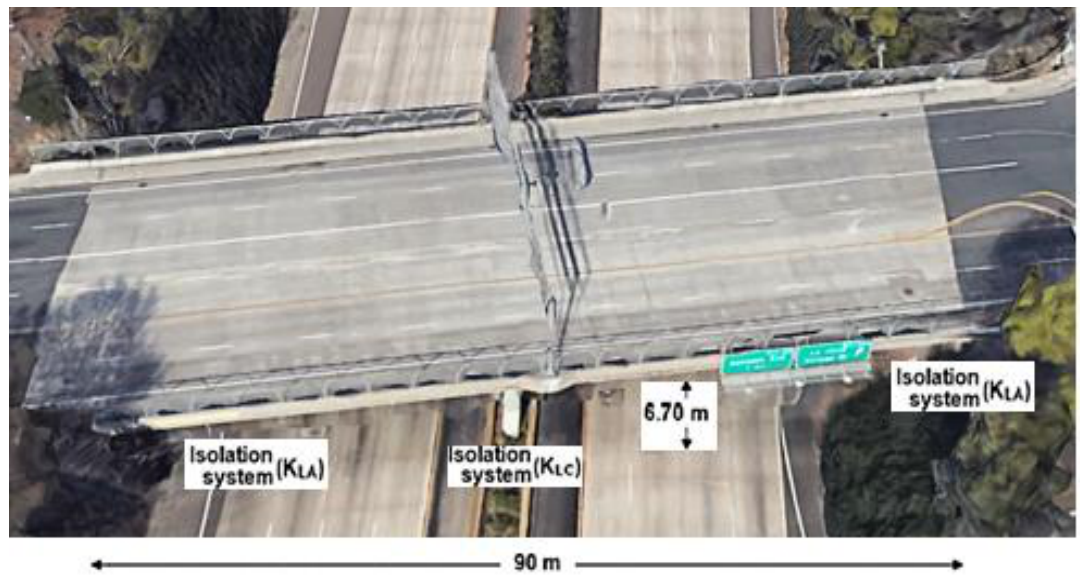
Figure 1. Benchmark